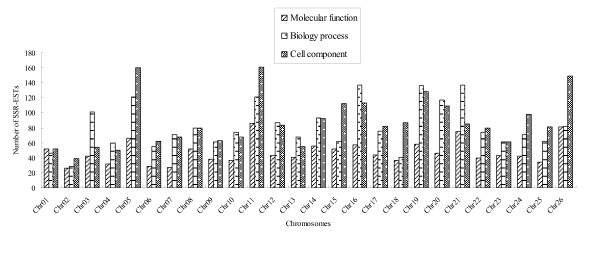
Chromosome distribution of GO catalogs.